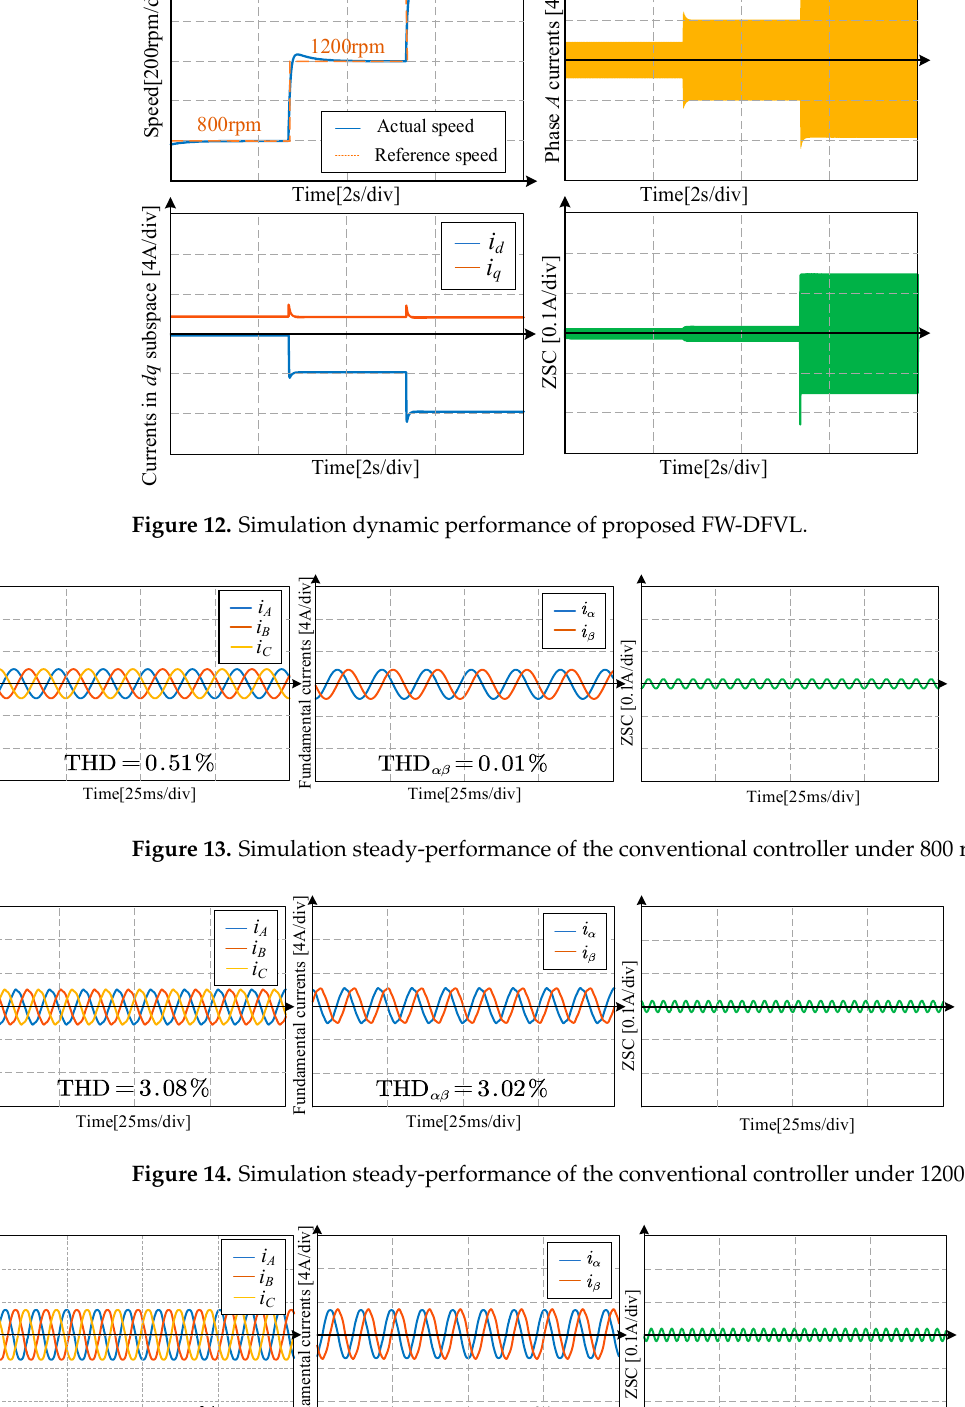
Figure 14. Simulation steady-performance of the conventional controller under 1200 rpm reference.